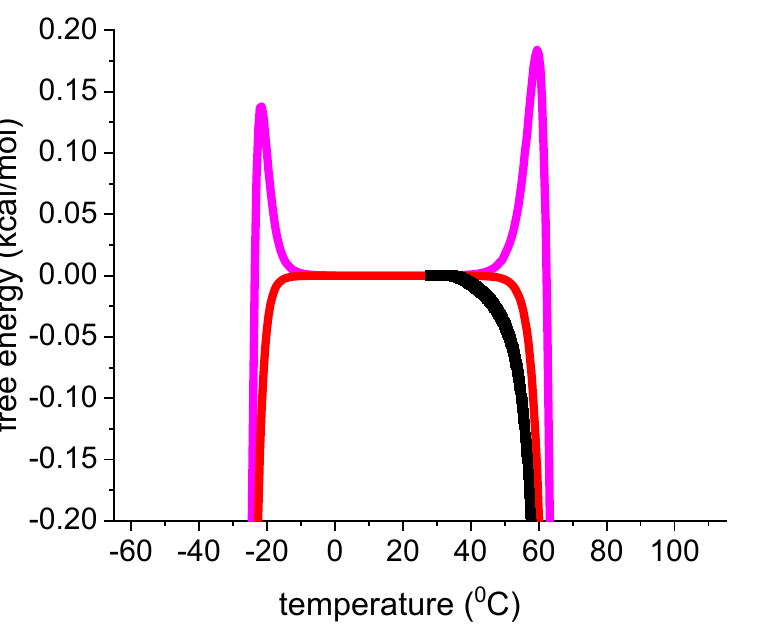
Figure 7. Enlarged view of the free energy. Black data points: DSC results for lysozyme heat unfolding. Red line: statistical mechanical two-state model ( ∆ E 0 = 110 kcal/mol, C v = 1.05 kcal/mol). Magenta line: Θ U (T)-weighted chemical equilibrium two-state model (Equation (17), ∆ H 0 = 1107 kcal/mol, ∆ C 0 p = 2.27